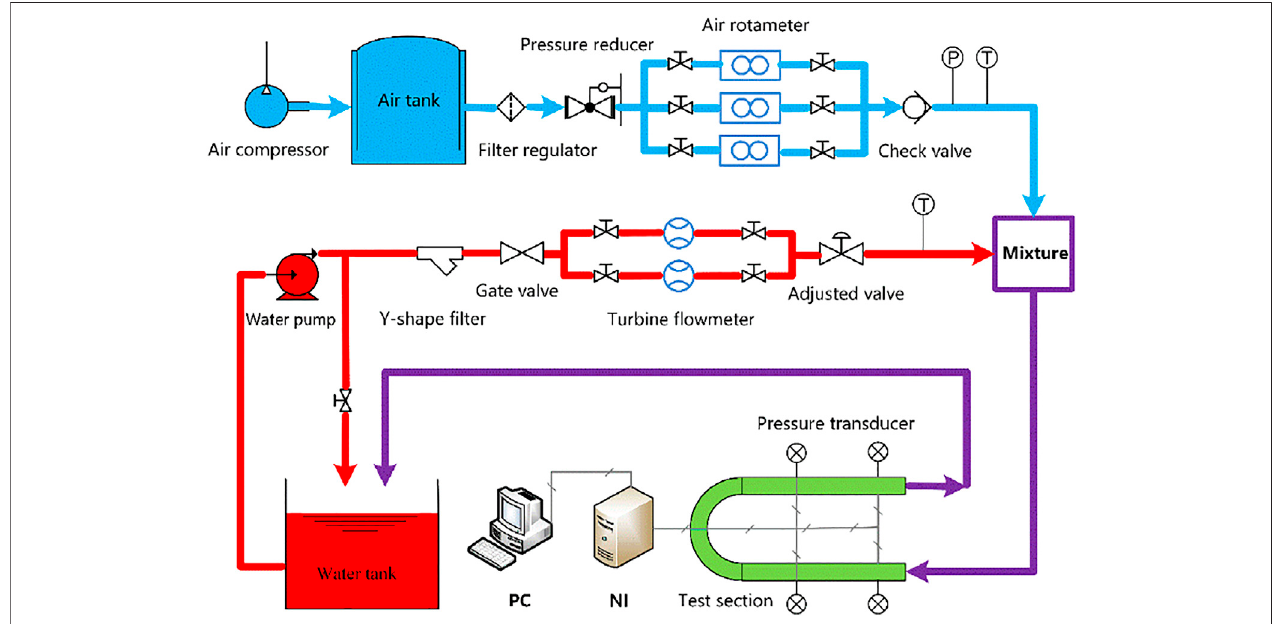
FIGURE 1 | Schematic diagram of the experimental